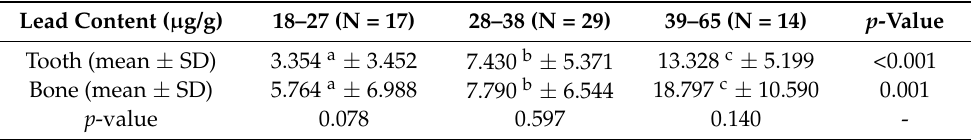
Table 8. Lead content in tested samples taken from patients of different age.